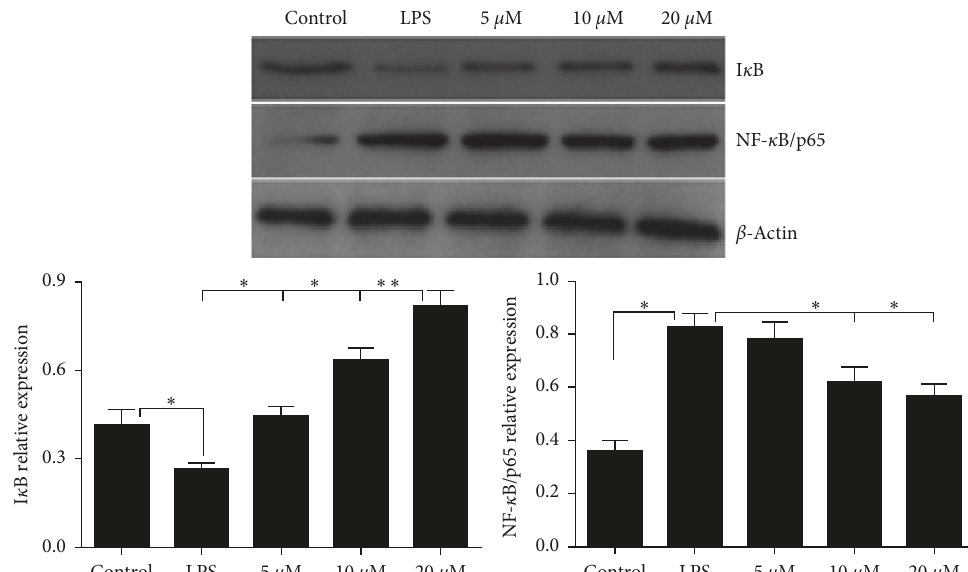
Figure 5: The effect of physalin B on LPS-induced NF- κ B activation in RAW264.7 cells. RAW264.7 cells were treated with different concentrations of physalin B (5, 10, and 20 μ M) for 2h and then stimulated with 1 µ g/ml LPS for 30min. Nuclear extract was prepared, and the translocation of NF- κ B subunits to nucleus was analyzed by Western blot analysis using specific antibodies. Cytoplasmic extract was also prepared, and I κ B expression was analyzed. Three independent experiments were